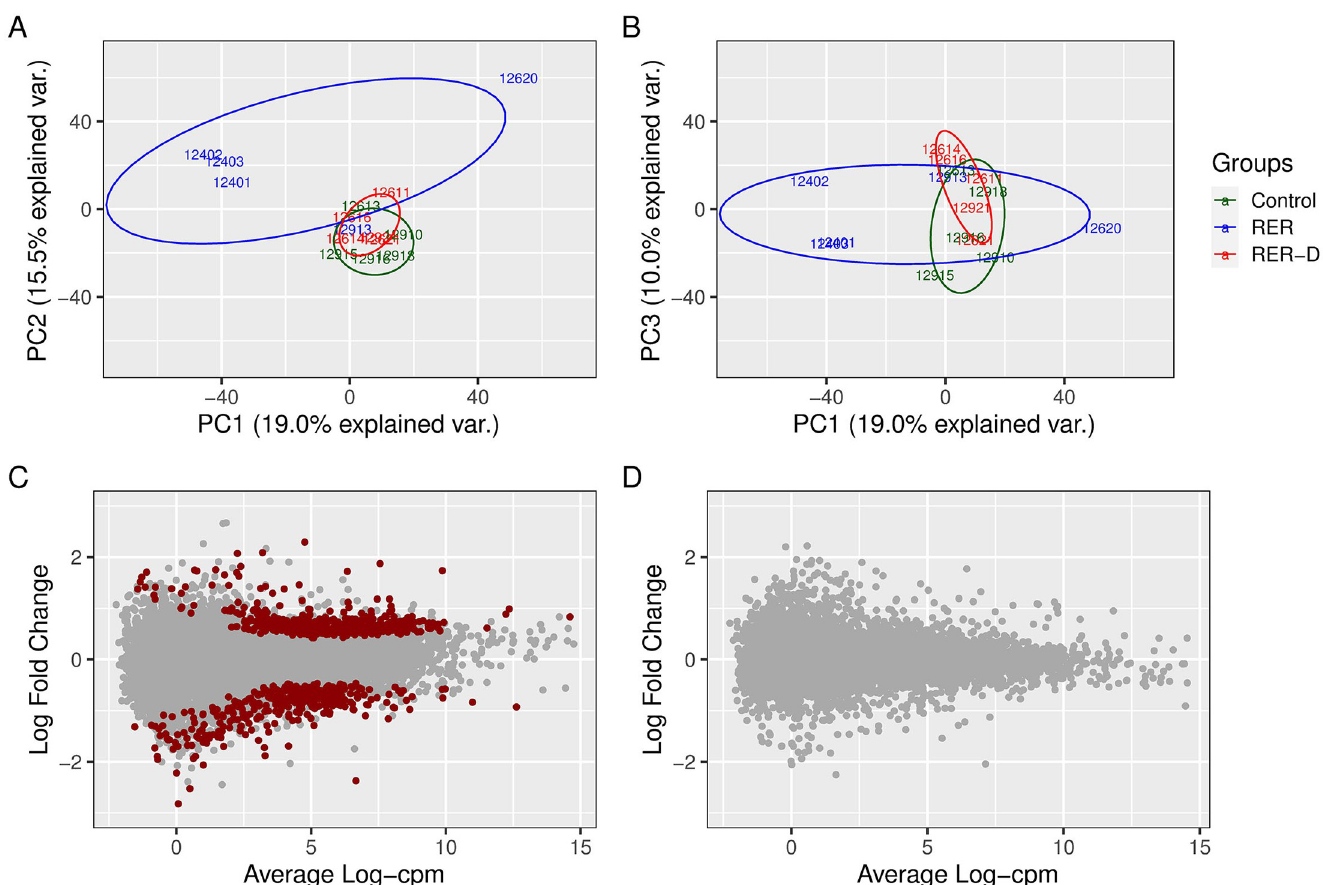
Fig 6. Principal component (PC) analysis of transcriptomic data for control, RER-susceptible (RER) and RER horses treated with dantrolene (RER-D). (A) PC1 versus PC2. Note that RER-susceptible horses cluster separately from overlapping RER-D and controls. (B) PC1 and PC3. The proportion of variance explained by the RER and control groups is reduced by PC3. (C) MA plot depicting the average expression of gene transcripts compared to the log 2 fold change of differentially expressed genes comparing RER-susceptible to controls. There were 812 differentially expressed genes (red dots) between RER-susceptible and control horses. (D) MA plot showing the average expression of gene transcripts compared to the log 2 fold difference in differentially expressed genes in RER-D compared to controls. There were no significant differentially expressed genes observed between RER-D and controls.